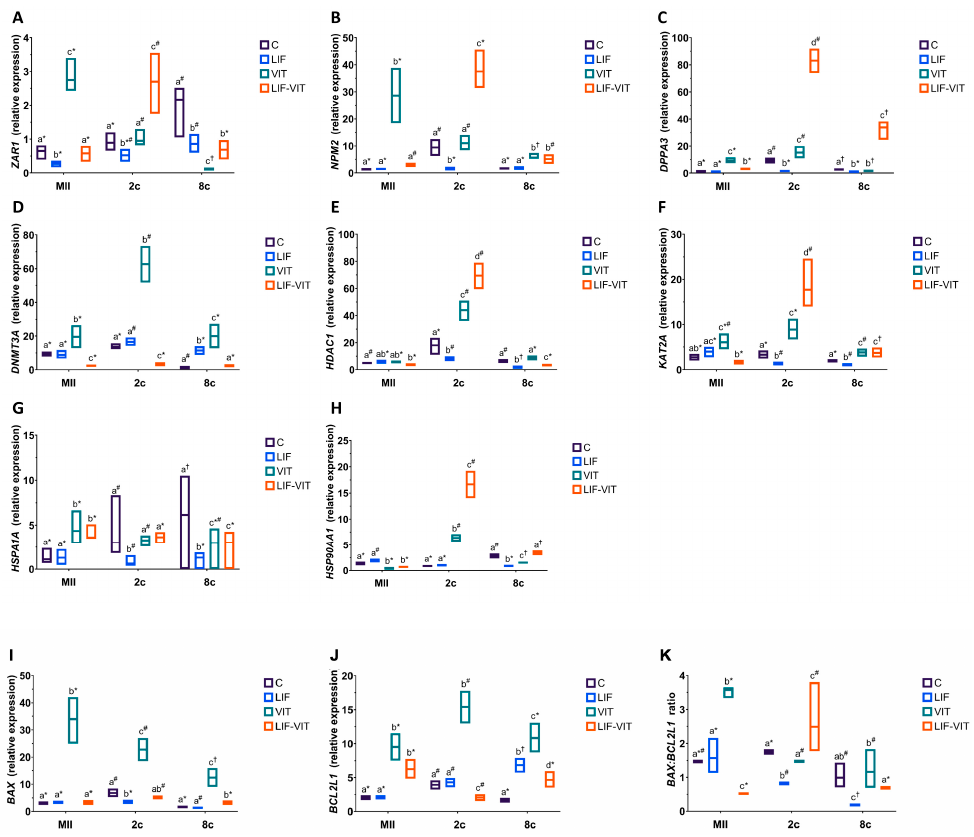
Figure 4. ( A ) ZAR1 , ( B ) NPM2 , ( C ) DPPA3 ( D ) DNMT3A , ( E ) HDAC1, ( F ) KAT2A, ( G ) HSPA1A , ( H